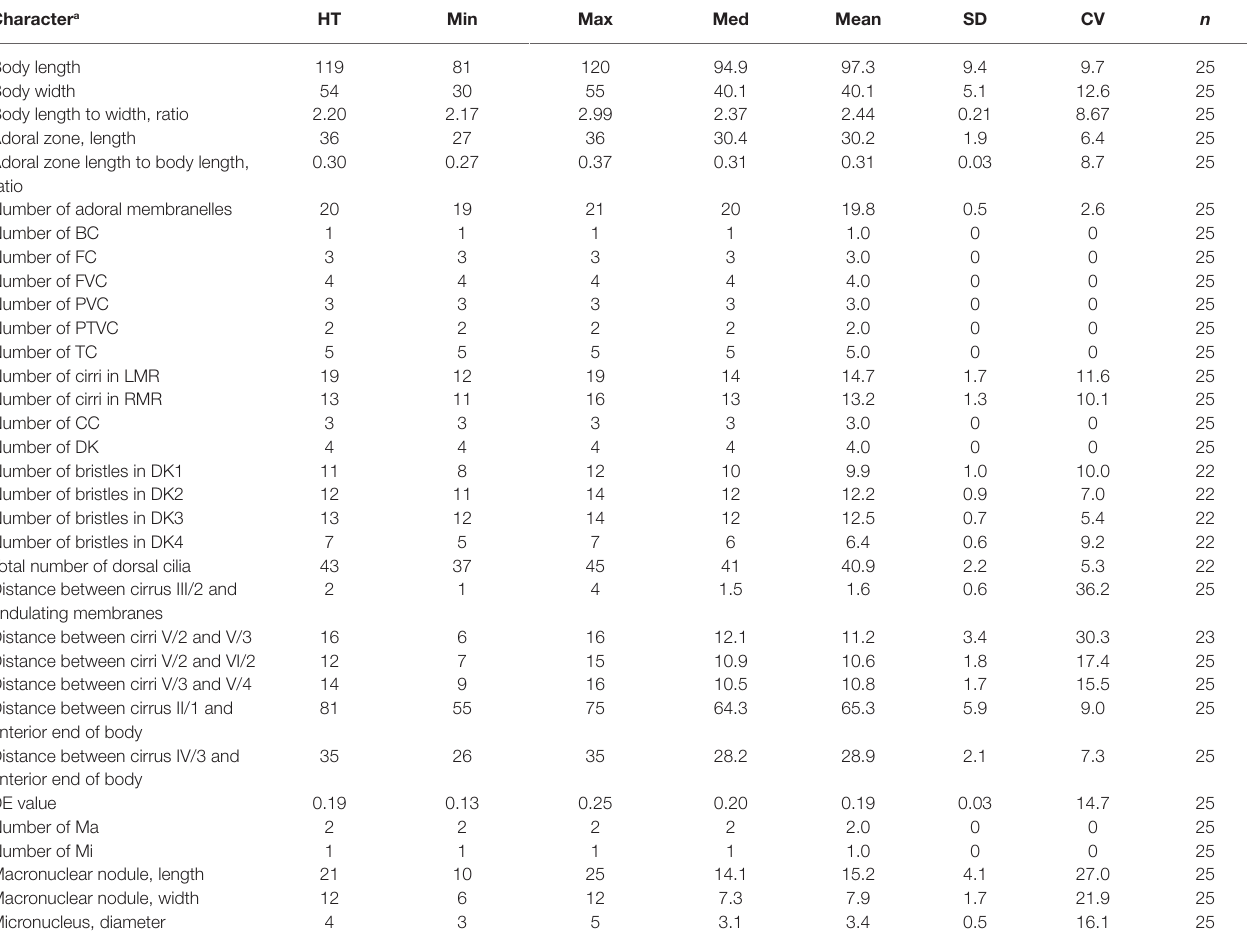
TABLE 1 | Morphometric characterization of Quadristicha subtropica n.